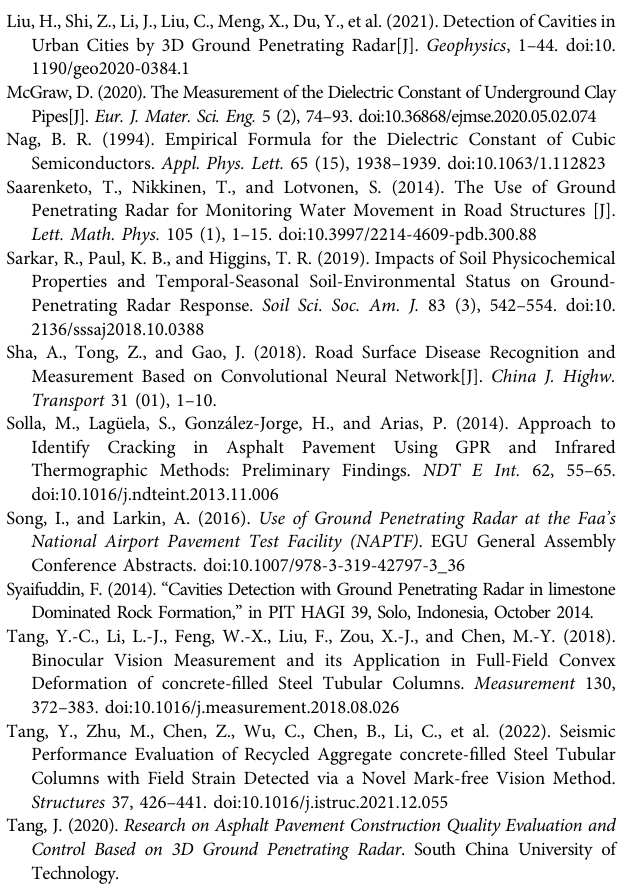
algorithm cannot complete the task of void bottom